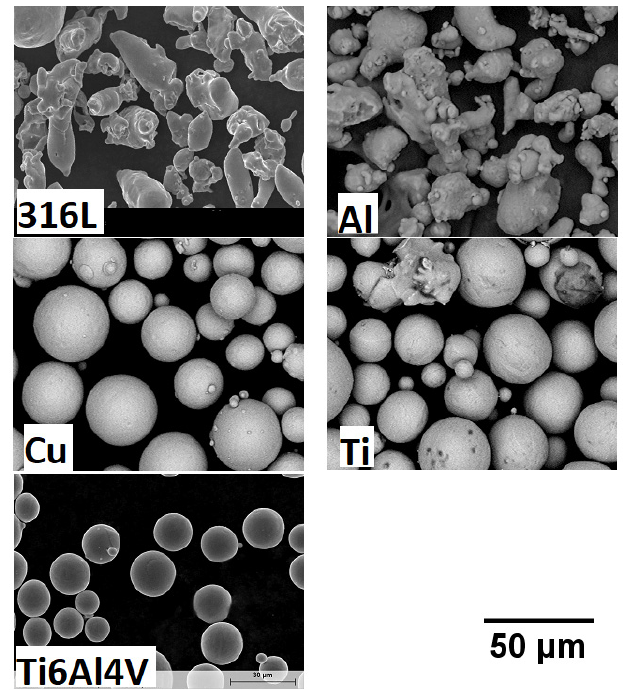
Figure 3. SEM images of feedstock powders for CSAM.